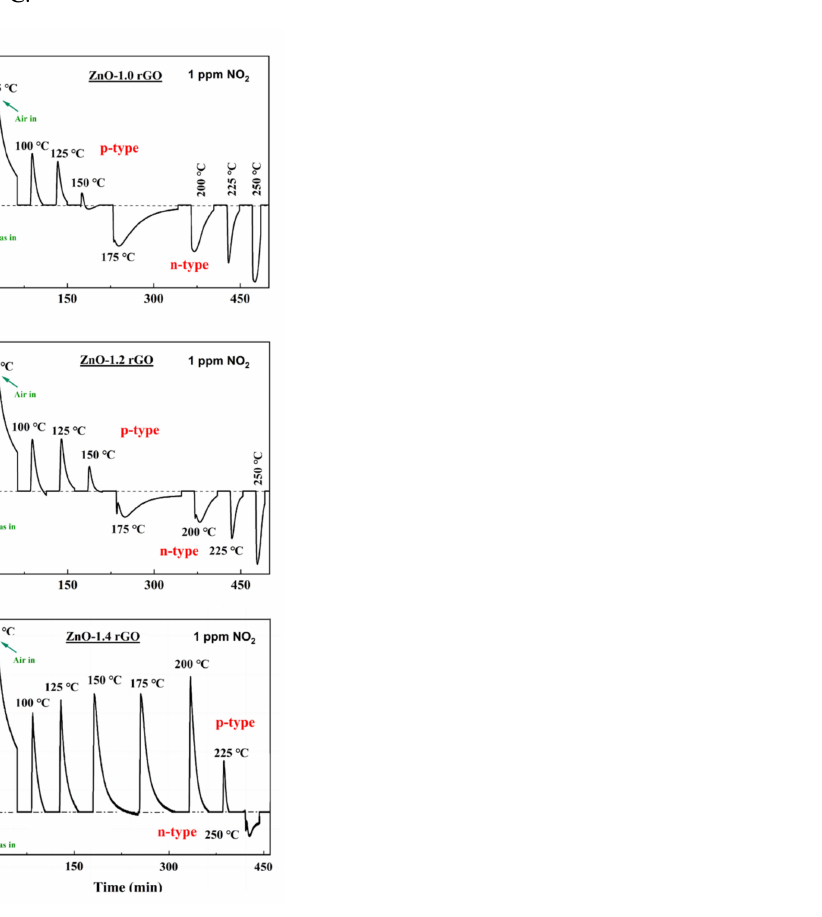
Figure 9. Dynamic sensing transients of ( a ) ZnO-1.0% rGO, ( b ) ZnO-1.2% rGO and ( c ) ZnO-1.4% rGO at 1 ppm to 30–225 ◦